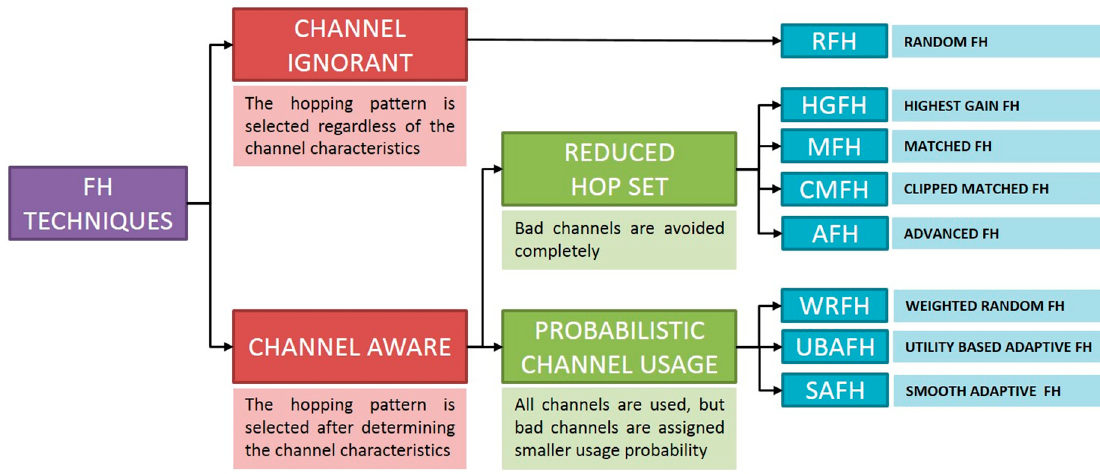
Figure 6. Classification of frequency hopping techniques.